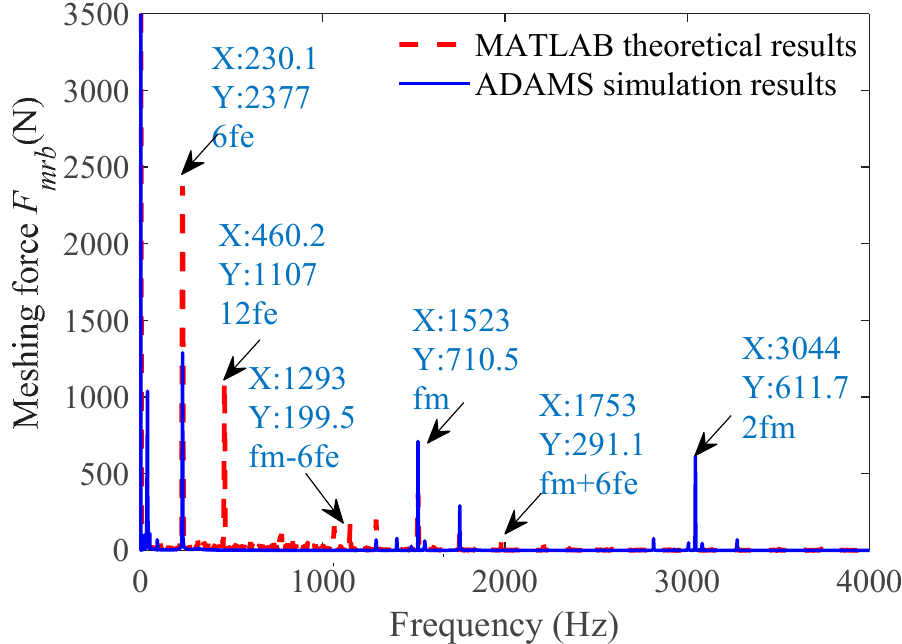
Figure 23. Frequency spectrum and time–frequency spectrum of meshing force F mrb